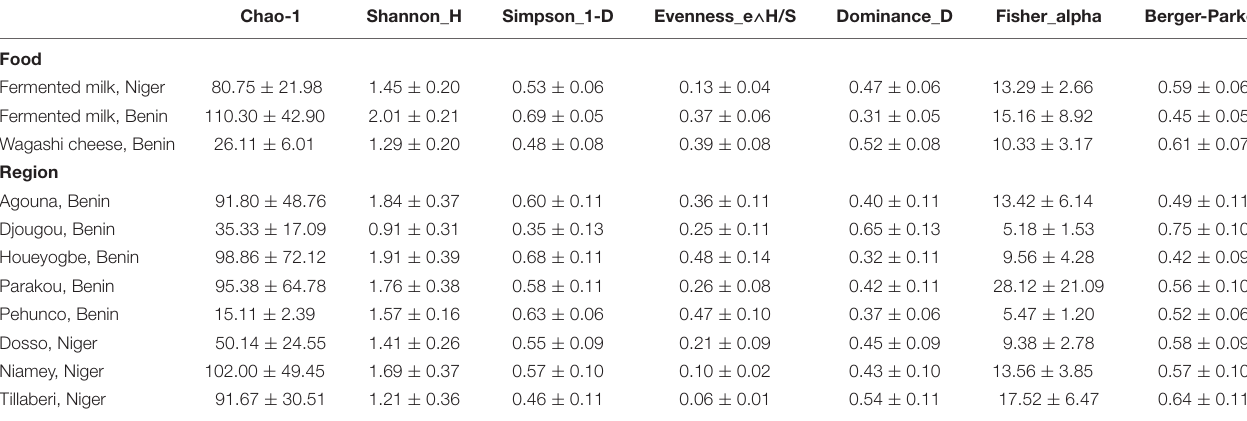
TABLE 1 | Yeast diversity in fermented milk products collected from different regions of Benin and Niger. Chao-1